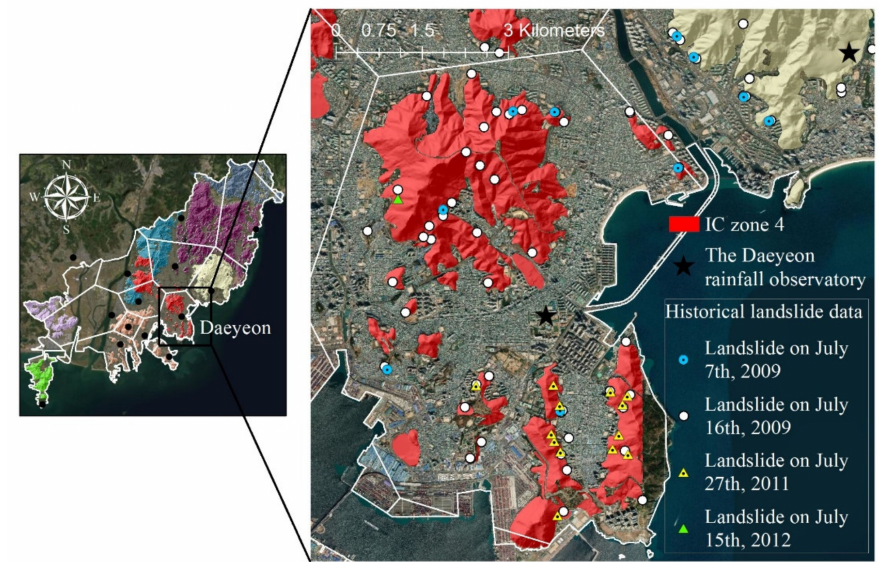
Figure 12. Map of the study region used for temporal performance analysis including the distribution of historical landslides recorded on four di ff erent dates.